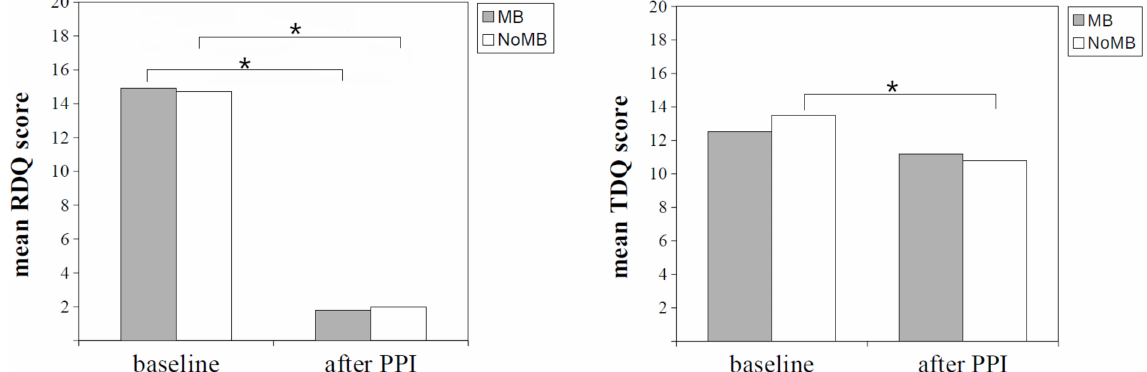
Figure 2. Bar chart illustrating the RDQ and TDQ scores before and after PPI therapy. MB, mucosal break; NoMB, no mucosal break; PPI, proton-pump inhibitors; RDQ, reflux disease questionnaire; TDQ, Taiwanese depression questionnaire. * p -value < 0.05.